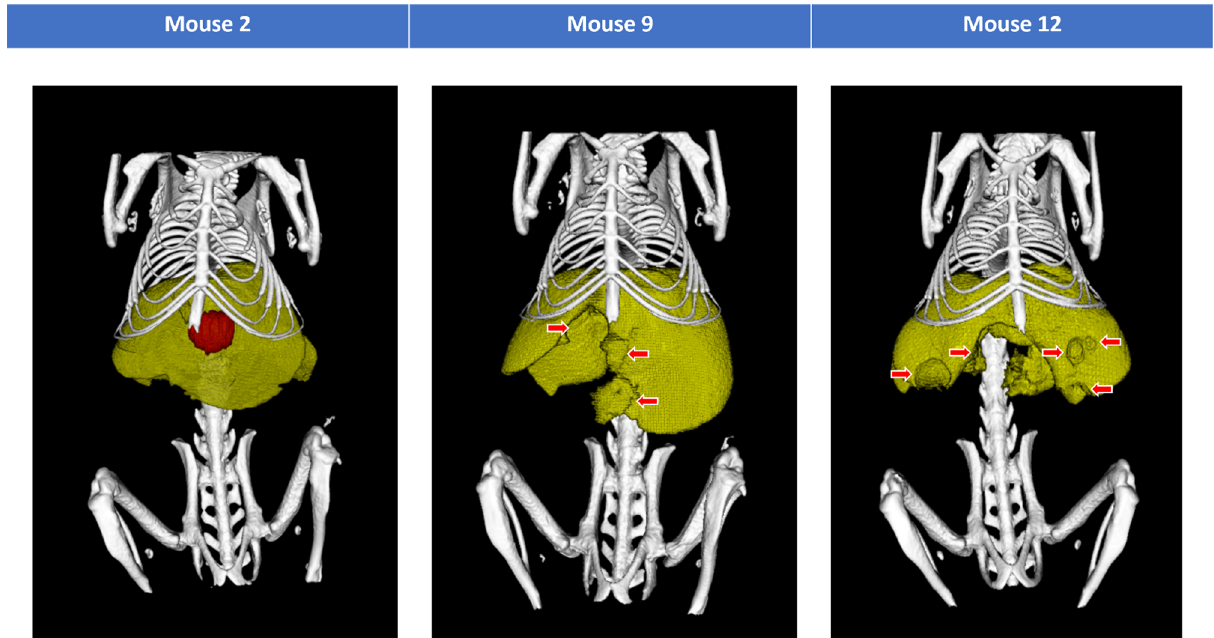
Figure 5. 3D models of tumor burden. Mouse 2 with a single tumor nodule (red sphere) fully enclosed in its liver (yellow) is the light tumor burden. Mouse 9 with several tumor nodules (red arrows) that grew inside the liver (yellow) represents the medium tumor burden. Mouse 12 with a tumor mass (red arrow pointing to the large gap in the center of the liver) surrounded by several tumor nodules (red arrows pointing to the spherical indentations) inside its liver (yellow) represents the heavy tumor